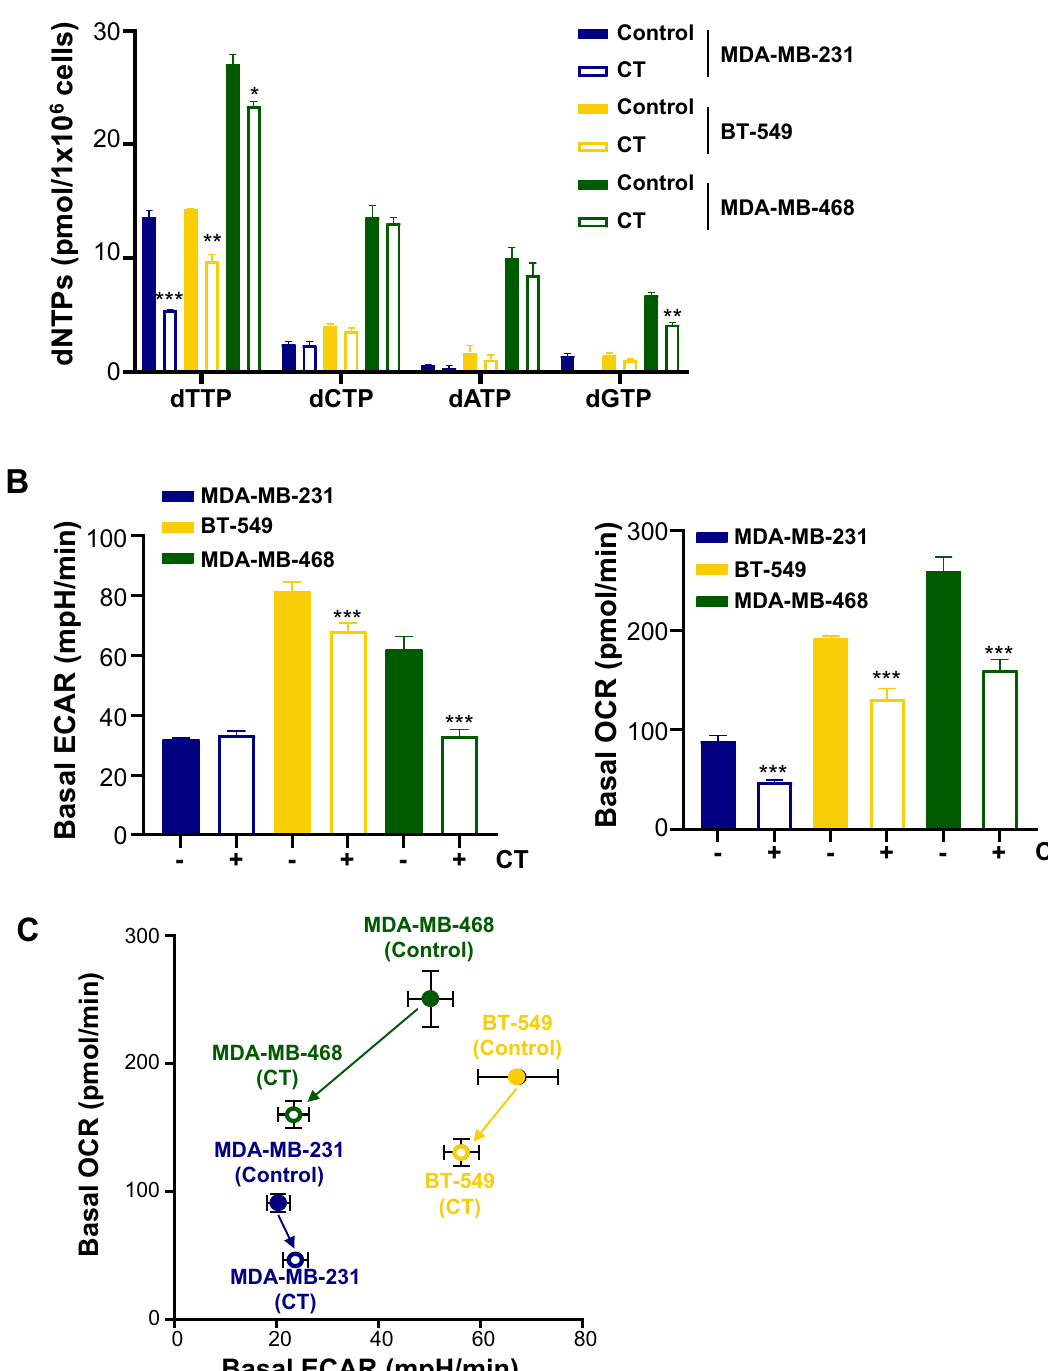
Figure 8. Metabolic effects of CT mRNA transfection in TNBC cells. ( A ) Change of intracellular dNTP pools in TNBC cells by CT transfection. EvaGreen-based assay for dNTPs using 197-nt templates was carried out for quantification of dNTP pools in TNBC cells after CT transfection (1.25 μg/5 × 10 5 cells). ( B ) Basal ECAR and OCR of TNBC cells transfected by CT. ( C ) Metabolic shift by CT transfection plotted from relative OCR and ECAR data from ( B ). Relative OCR and ECAR data were plotted simultaneously to reveal changes of overall relative basal metabolic profiles for each TNBC cell. The length between control and CT indicated the degree of metabolic shift. ( D ) The ratios of apoptotic cells induced by transfecting CT to each TNBC cell line. In flow cytometry analysis, the ratio of apoptotic cells was proportional to the degree of metabolic shift. Annexin V-FITC positive/PI-PE negative cells and annexin V-FITC/PI-PE double-positive cells were judged to be in the early and late stages of apoptosis,